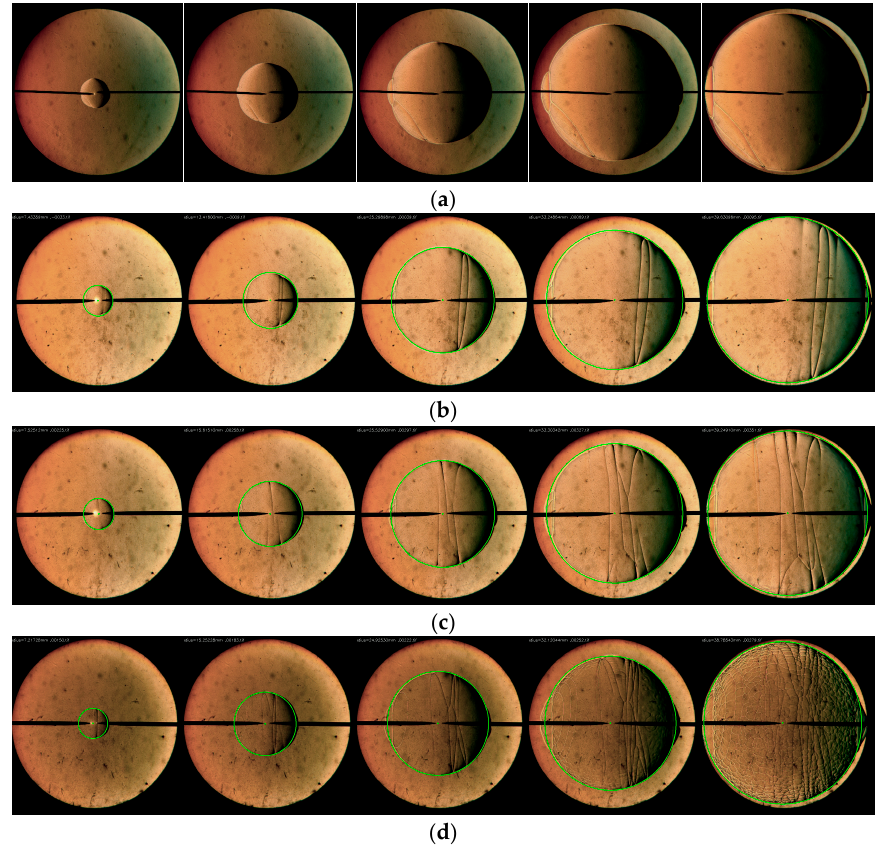
R = 0.0; ( b ) R = 0.0; ( b ) R H = 0.1; 2 H 2 H 2 2